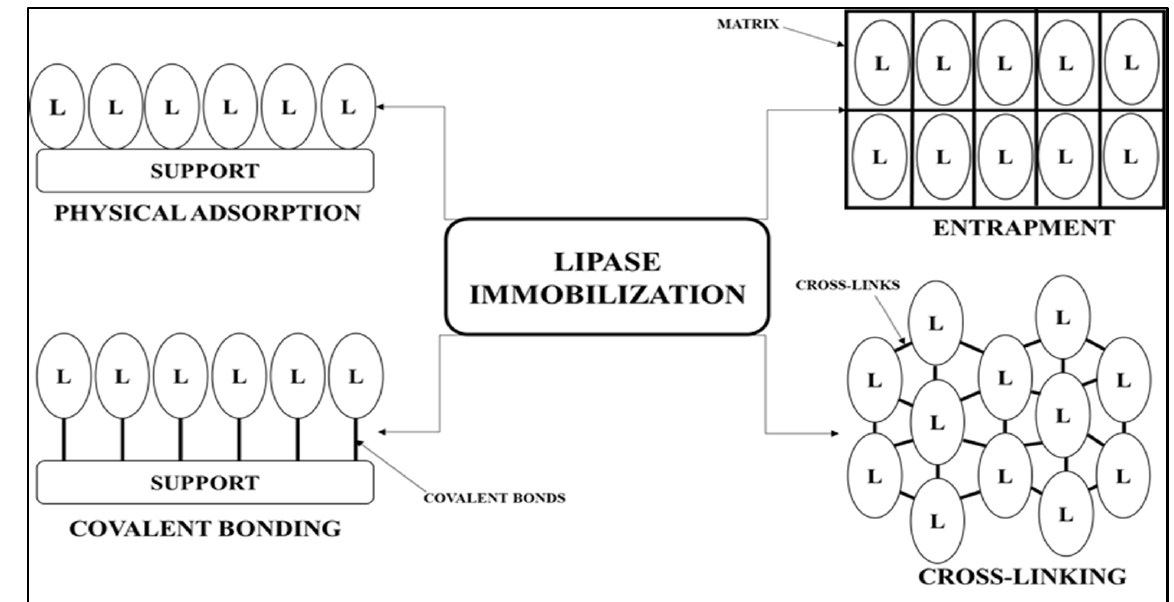
Figure 2. The simplified division of immobilization techniques. “L” indicates a lipase molecule.